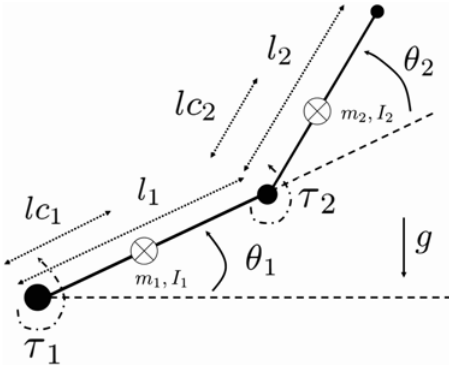
Figure 8. Mechanical model of the 2-dof human arm. The subscripts 1 and 2 denote the shoulder and elbow joints respectively. Generalized coordinates h , joint torque t , moment of inertia I , segment mass m , segment length to the center of mass lc , and gravity acceleration g are denoted.